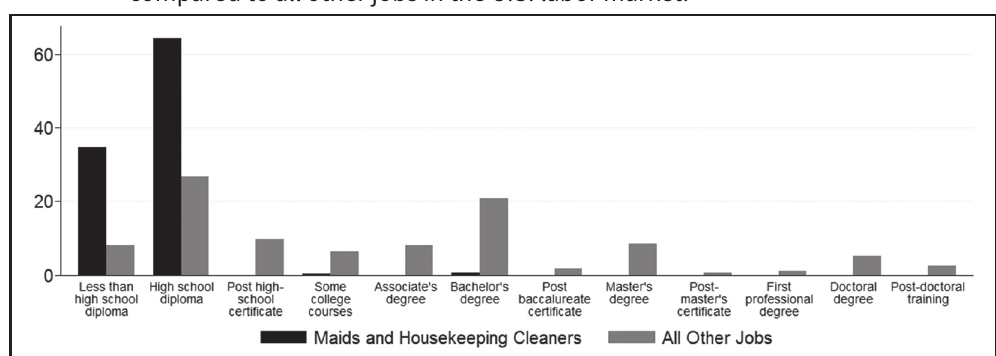
Figure 2 Distribution of educational requirements for maids and housekeeping cleaners compared to all other jobs in the U.S. labor